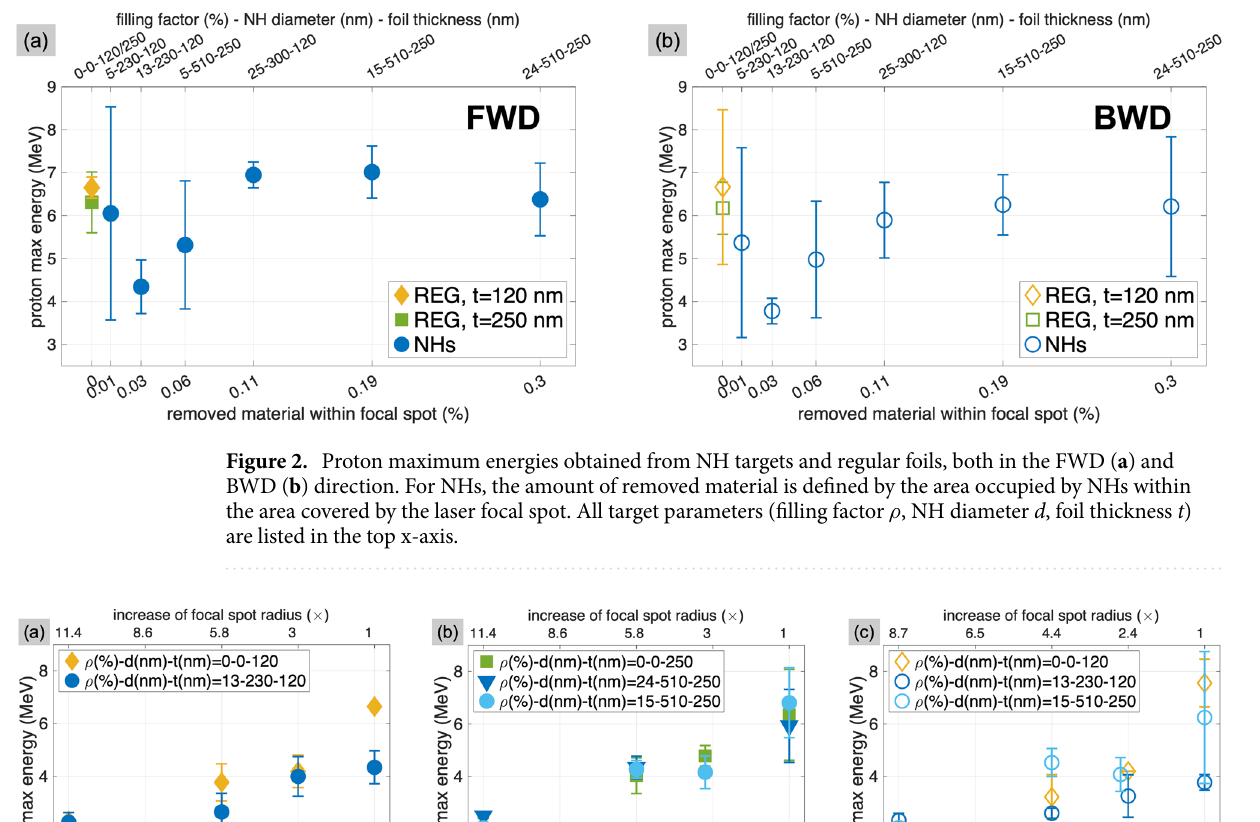
0.5 1 ( z / z R ) 2 , with [ + ]